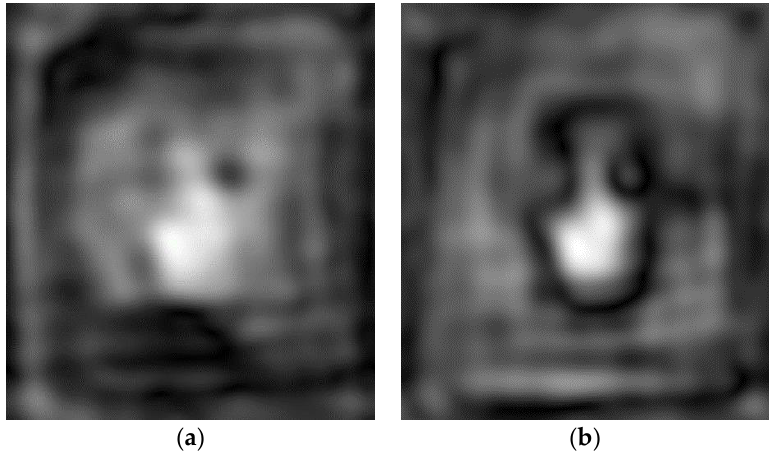
Figure 34. ( a ) Cast and mold cleanly mated and ( b ) separated by a <1 mm slip of sand. Other experiments that used HSR on paleontological samples include a partially exposed rostrum of an Upper Jurassic to Lower Cretaceous fossil crocodylomorph in a 21-mm-thick limestone slab from the Maiolica Formation. The specimen, recovered in the Altopiano di Asiago (Vicenza Province, Italy), is presently housed in the paleontological collections of the Rovereto Civic Museum (Trento Province, Italy). The holographic radar response recorded on the surface where the fossil cannot be observed correlates well with the actual fossil shape revealed on the reverse side of the slab. This study was done using a RASCAN-4/7000 HSR radar with discrete signals at frequencies between 6.4 GHz and 6.8